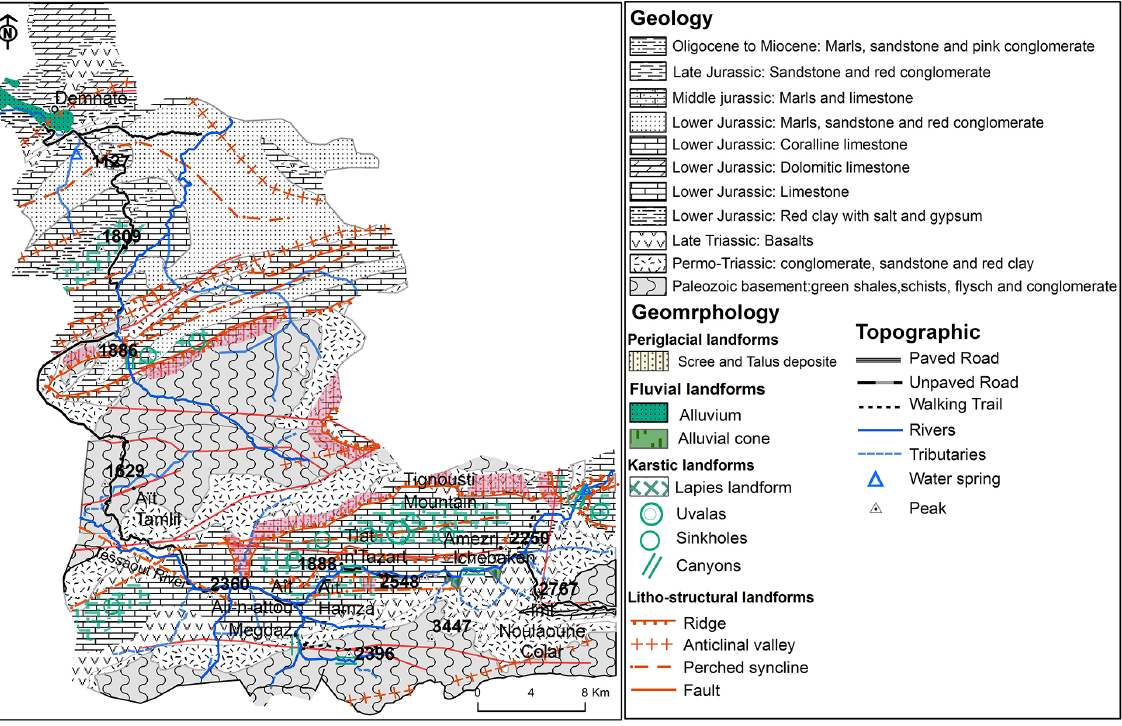
Fig. 2. Geomorphological map of the study